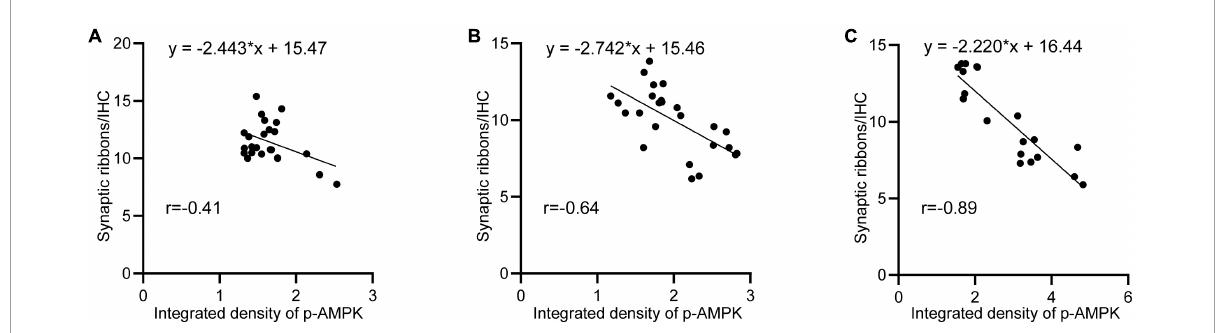
FIGURE10 Negative correlation between p-AMPK and the amount of ribbon synapses. (A) Linear regression analysis of p-AMPK intensity and the number of ribbon synapses at D0, D3, D7, and D14 in the 65SC and 65SC+NE groups ( r = –0.41, p < 0.05). (B) Linear regression analysis of p-AMPK intensity versus the number of ribbon synapses at D0, D3, D7, and D14 in the 85SC and 85SC+NE groups ( r = –0.84, p < 0.05). (C) Linear regression analysis of p-AMPK intensity versus the number of ribbon synapses at D0, D3, D7, and D14 in the NE group ( r = –0.89, p < 0.001).